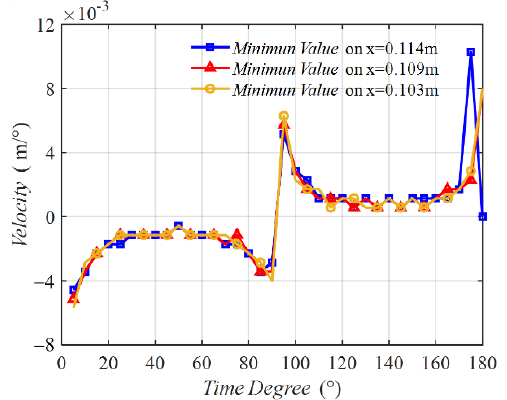
Figure 9. Velocity on three side lines varying with time degrees.